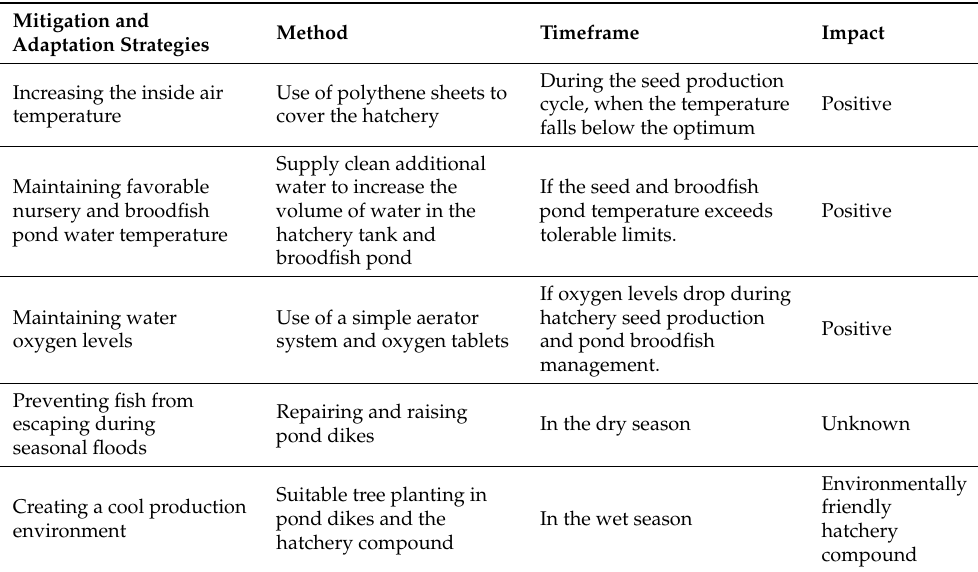
Table 7. Summary of the possible mitigation and adaptation measures under adverse climatic conditions as stated by hatchery